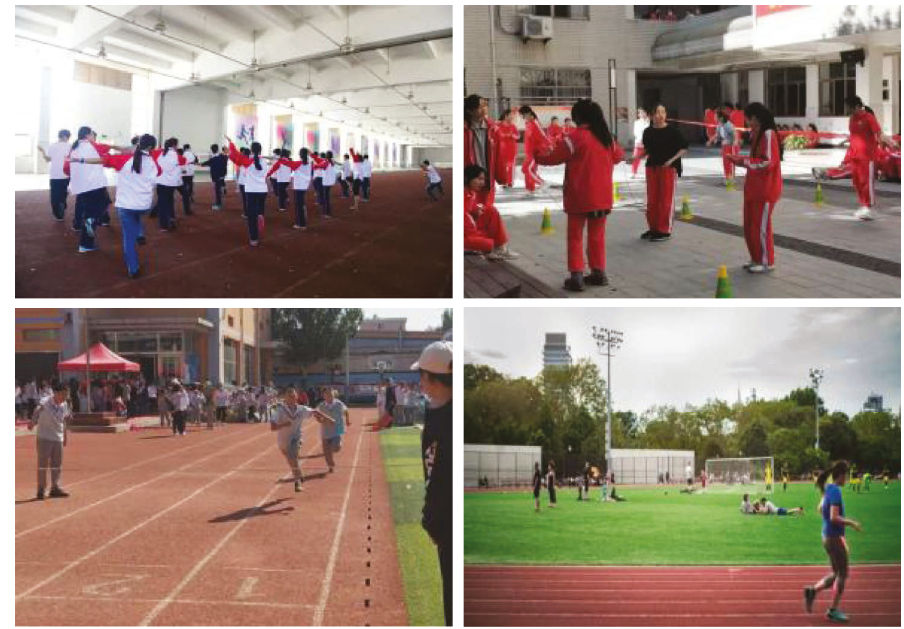
Figure 1: College students participating in sports activities.